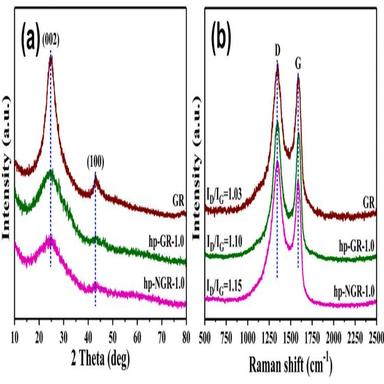
XRD patterns (a) and Raman spectra (b) of GR, hp-GR-1.0 and hp-NGR-1.0.